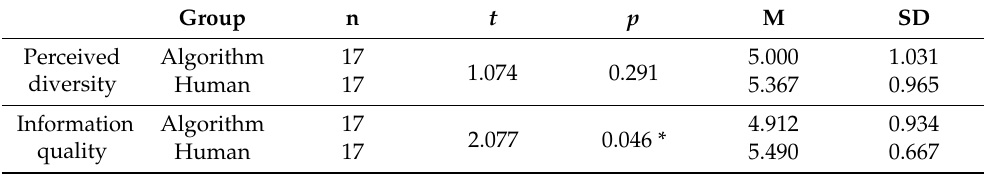
Table 6. Results of the two-way t-tests for H4a and